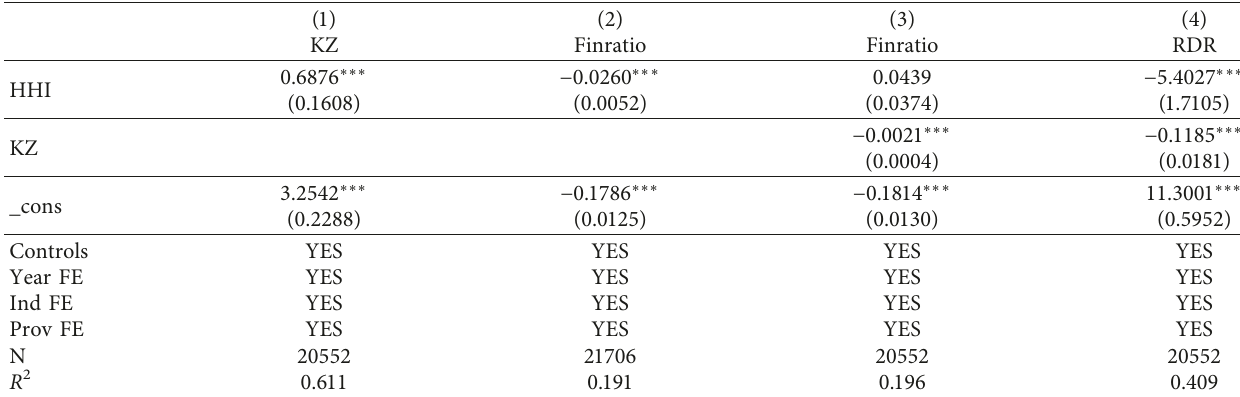
Table 6: Mechanism test results.